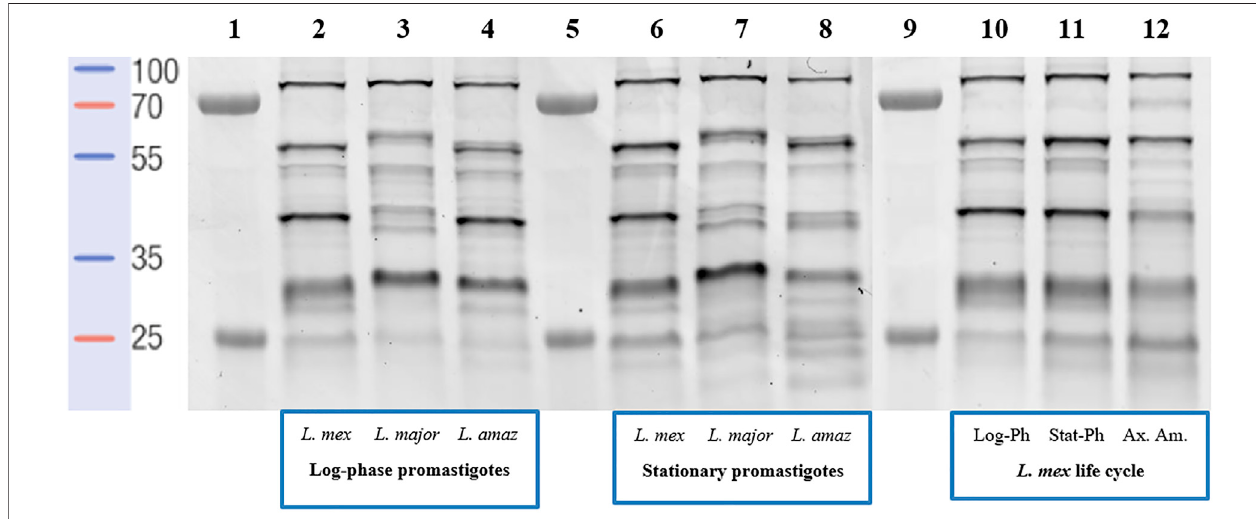
FIGURE 2 | In-gel fl uorescence analysis (emission at 560 nm) — serinome fi ngerprint of Leishmania spp. lysates (1 mg/ml) revealed by TAMRA-FP (1 μ M). Lane 1 : Markers; Lane 2 : Log-phase L. mexicana ; Lane 3 : Log-phase L. major ; Lane 4 : Log-phase L. amazonensis ; Lane 5 : Markers; Lane 6 : Stationary-phase L. mexicana ; Lane 7 : Stationary-phase L. major ; Lane 8 : Stationary-phase L. amazonensis ; Lane 9 : Markers; Lane 10 : Log-phase L. mexicana ; Lane 11 : Stationary-phase L. mexicana ; Lane 12 : Axenic amastigotes L. mexicana . DMSO was used as a negative control and pre-heated (95 ° C for 5 min) proteome solutions were used to verify FP-TAMRA probe speci fi city with no labelling being observed ( Supplementary Figures S2 – S4